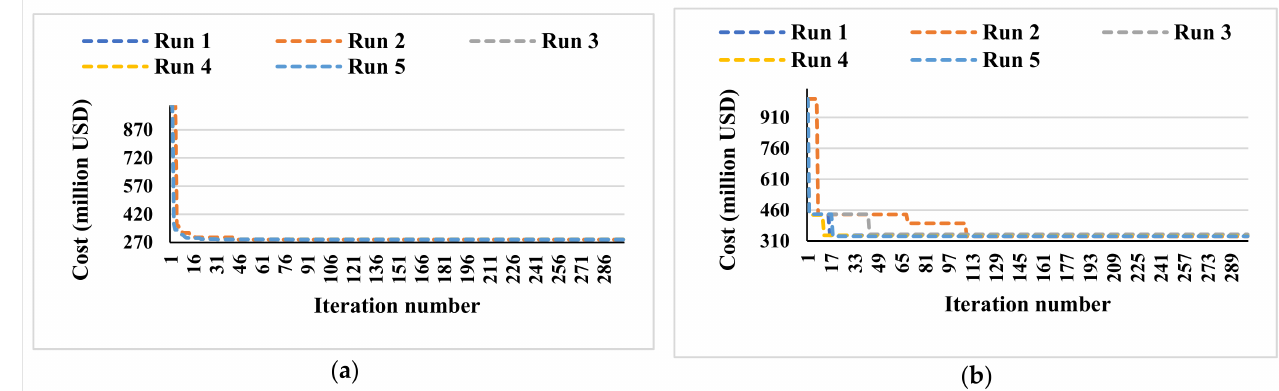
Figure 7. Convergence curves of the best five runs for the SCA and LFD for Scenario Number 25: ( a ) SCA, ( b ) LFD.